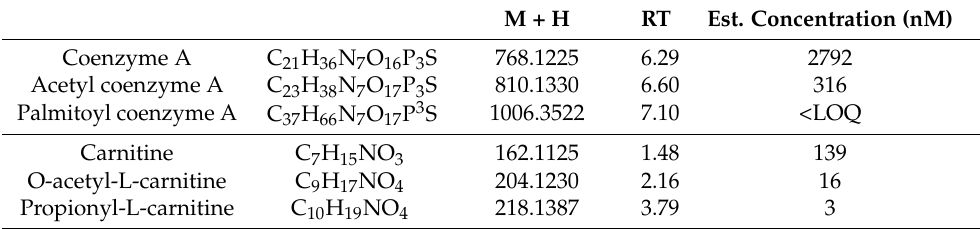
Figure A6. Fragmentation spectra of O-acetyl-L-carnitine in 5 µ M standard and ethanolic yeast extracts measured by neutral RP-HRMS in positive mode. Table A1. Estimated carnitine and coenzyme concentrations in ethanolic yeast extract determined using neutral RP ‐ HRMS and 5 μ M commercially available standards.